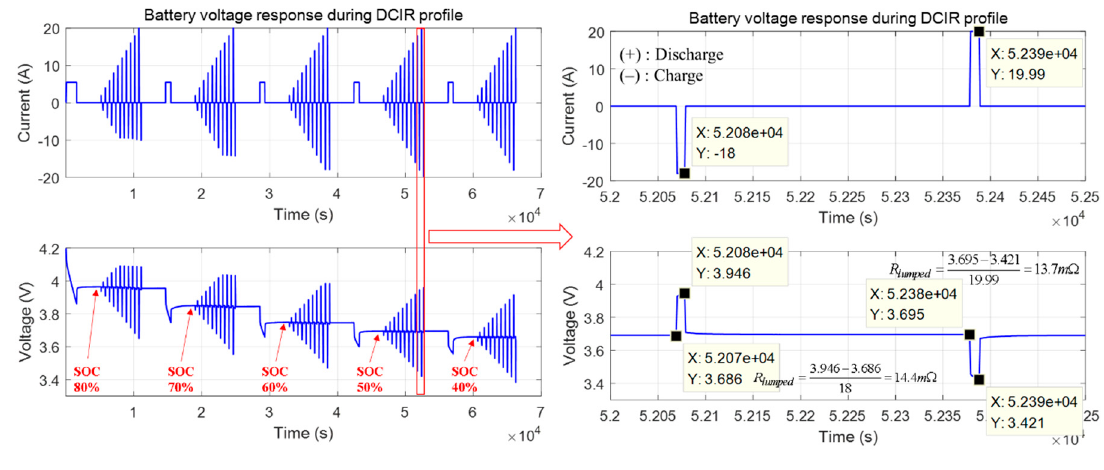
Figure 8. Current and voltage response of the battery cell under DCIR profile.